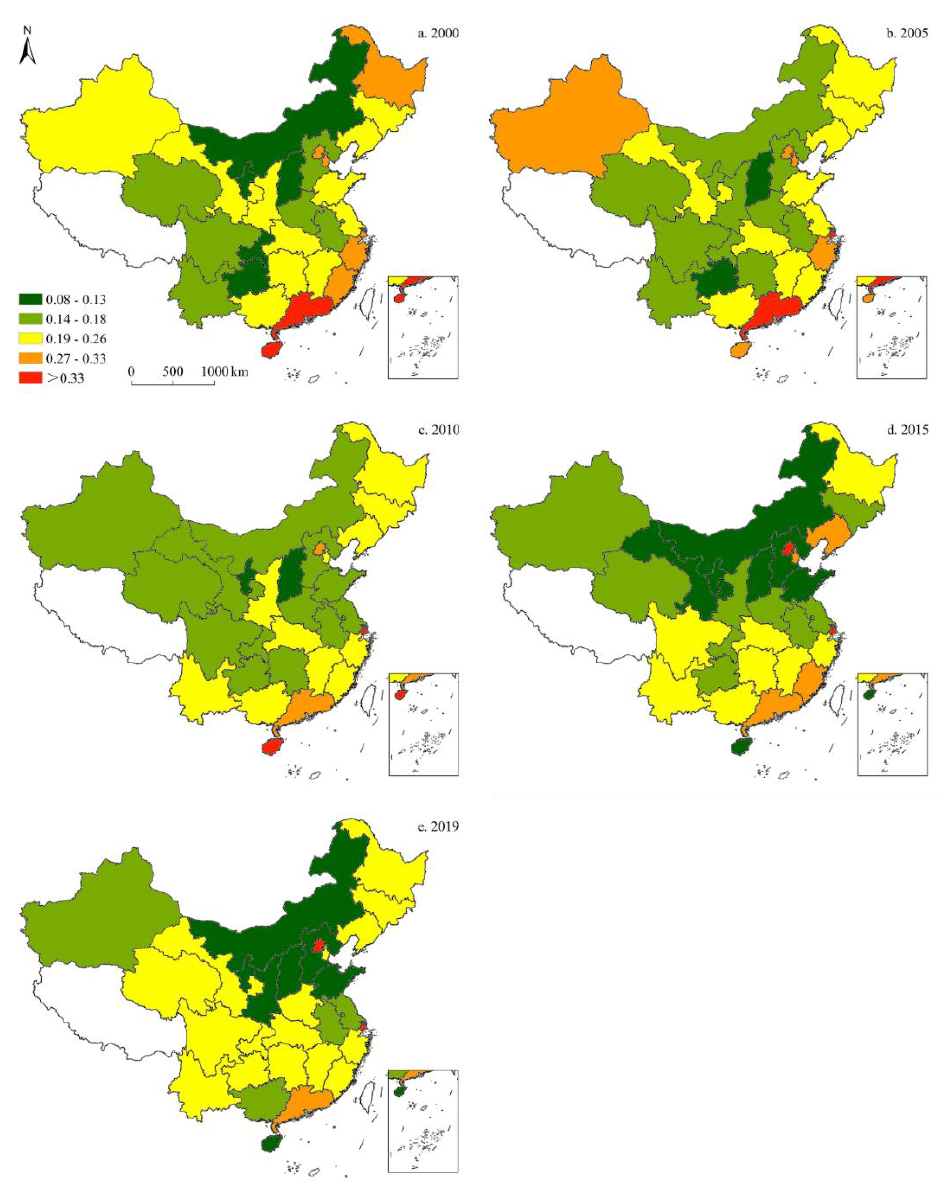
Figure 4. Spatiotemporal distribution of provincial-level petroleum consumption in China (five- time sections).